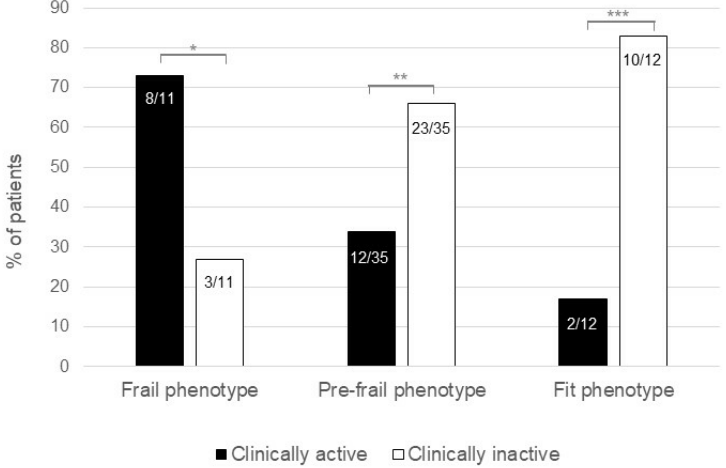
Figure 2. Changes in each component of the Fried frailty phenotype between the baseline and the end of the study. Di ff erence assessed with the McNemar test for unintentional weight loss, self- reported exhaustion, slow walking speed, low physical activity, and weakness was statistically signi fi cant for each item: * p < 0.0001, ** p = 0.012, *** p < 0.0001, **** p < 0.0001, ***** p < 0.0001.